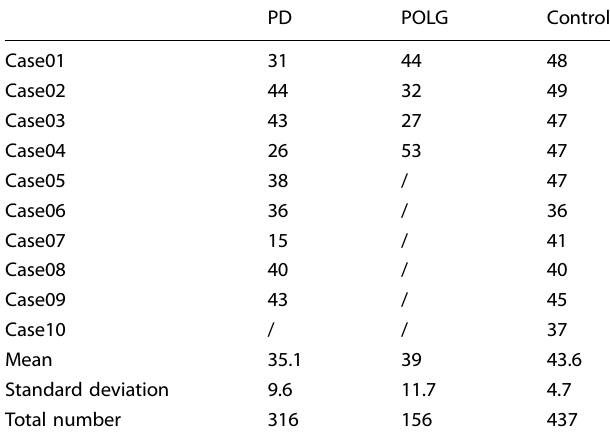
Table 2. The number of analysed neurons for this study. PD POLG Control